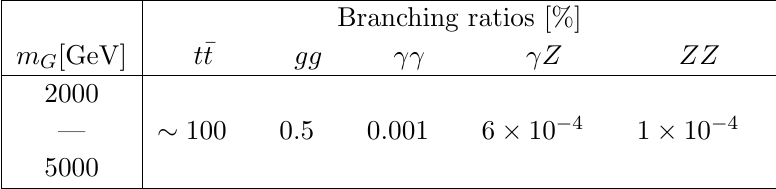
where (cid:27) ( pp ! G ) is the production cross section of the KK graviton and B( G ! XX 0 ) correspond to the branching ratios of the KK graviton decaying into the particle pairs of XX 0 with XX 0 = t (cid:22) t , gg , (cid:13)(cid:13) , (cid:13)Z , and ZZ . Figure 5 shows the KK graviton ( G ) total width divided by its mass, (cid:0) =m . Note that MadWidth [23] provides the partial decay rates G G numerically for each mass point. The resonance is very narrow as (cid:0) of 2{5 TeV of m with bench mark points of (cid:3) = 3 ; 5 ; 10 TeV. respectively. G